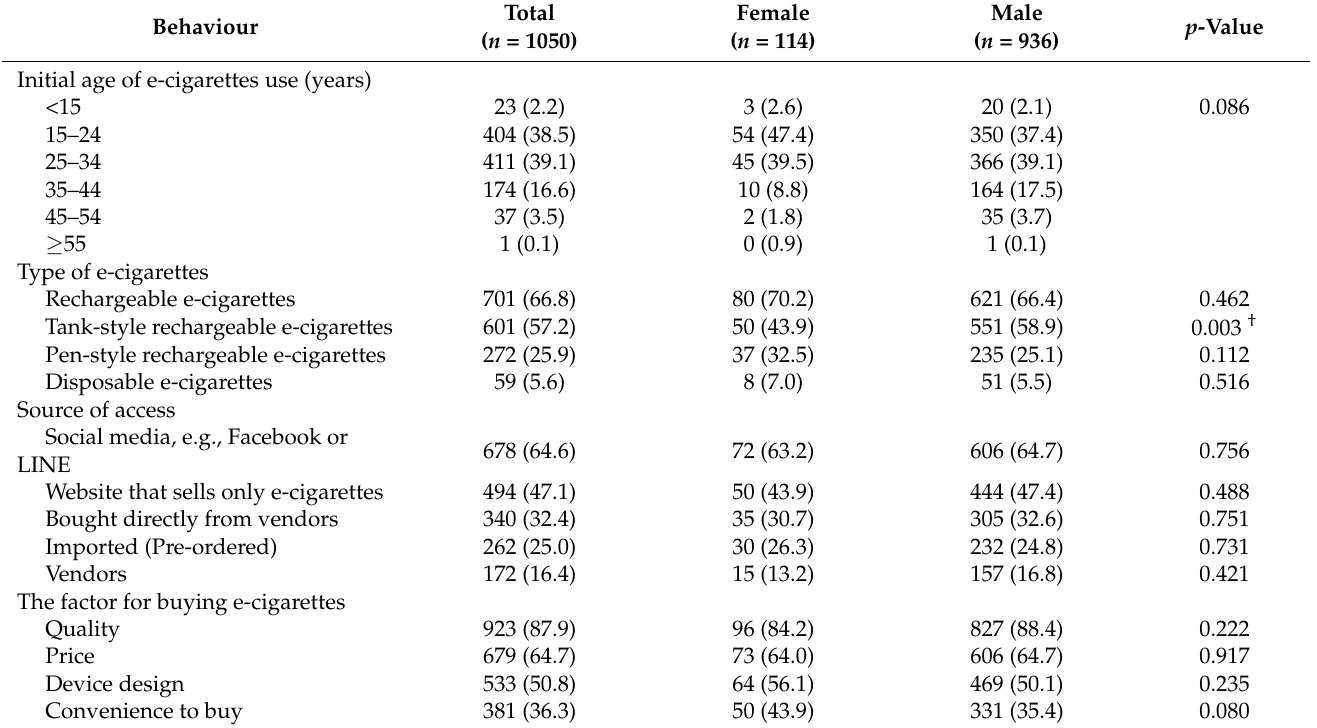
Table 2. Behaviour of e-cigarettes users by sex ( n = 1050).